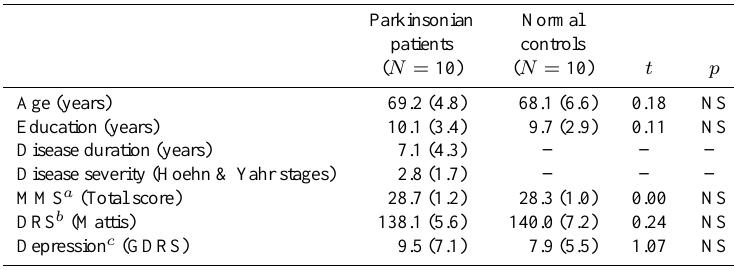
Table 1 Descriptive features of the